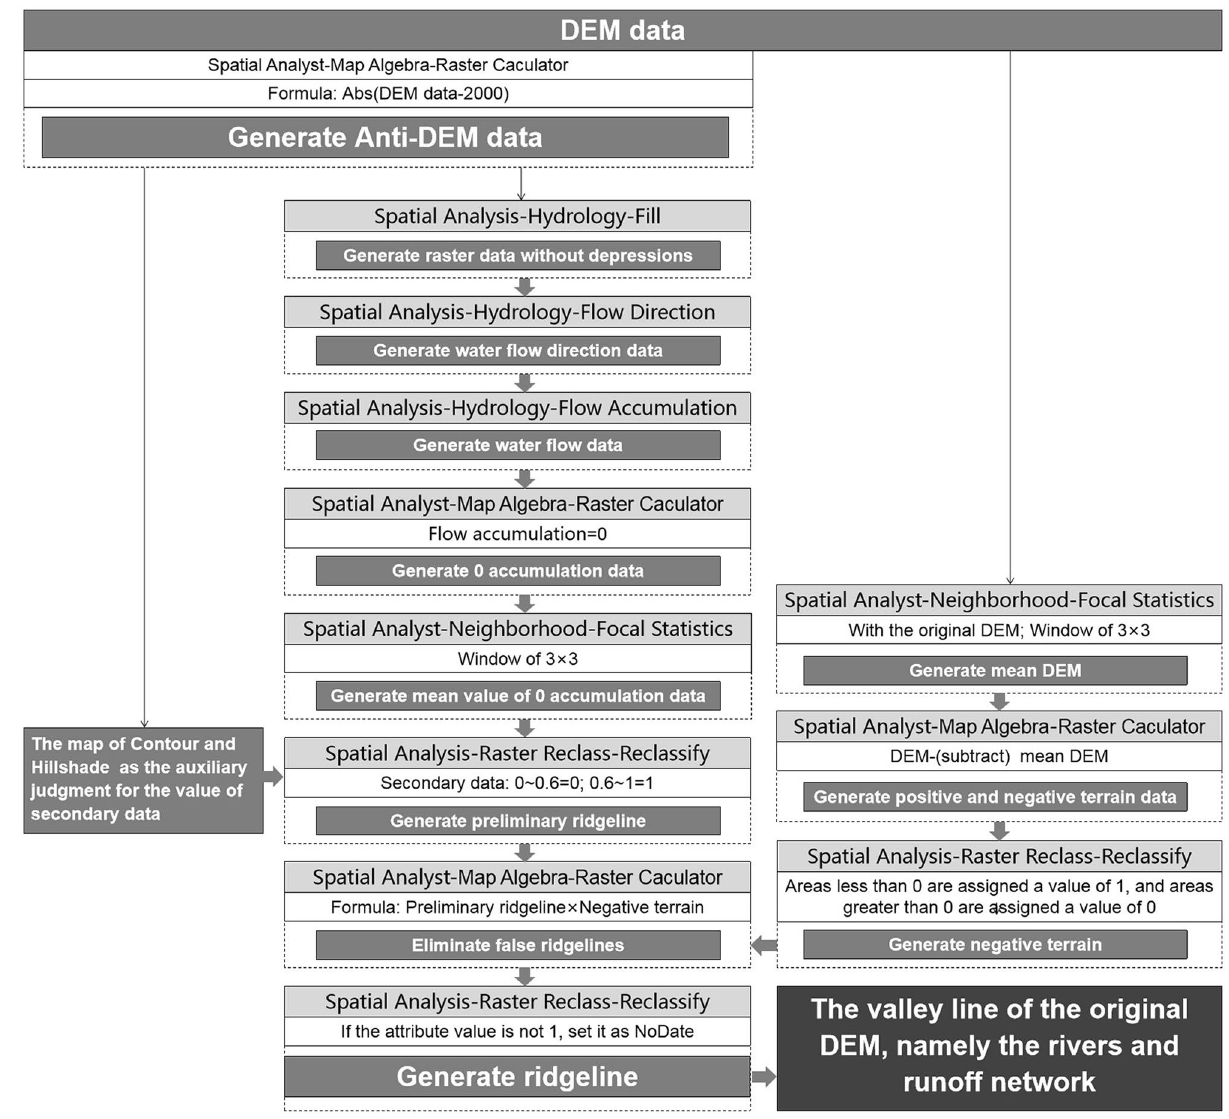
Figure 6. Process diagram for identification of Fujian’s rivers and runoff network by ArcGIS.